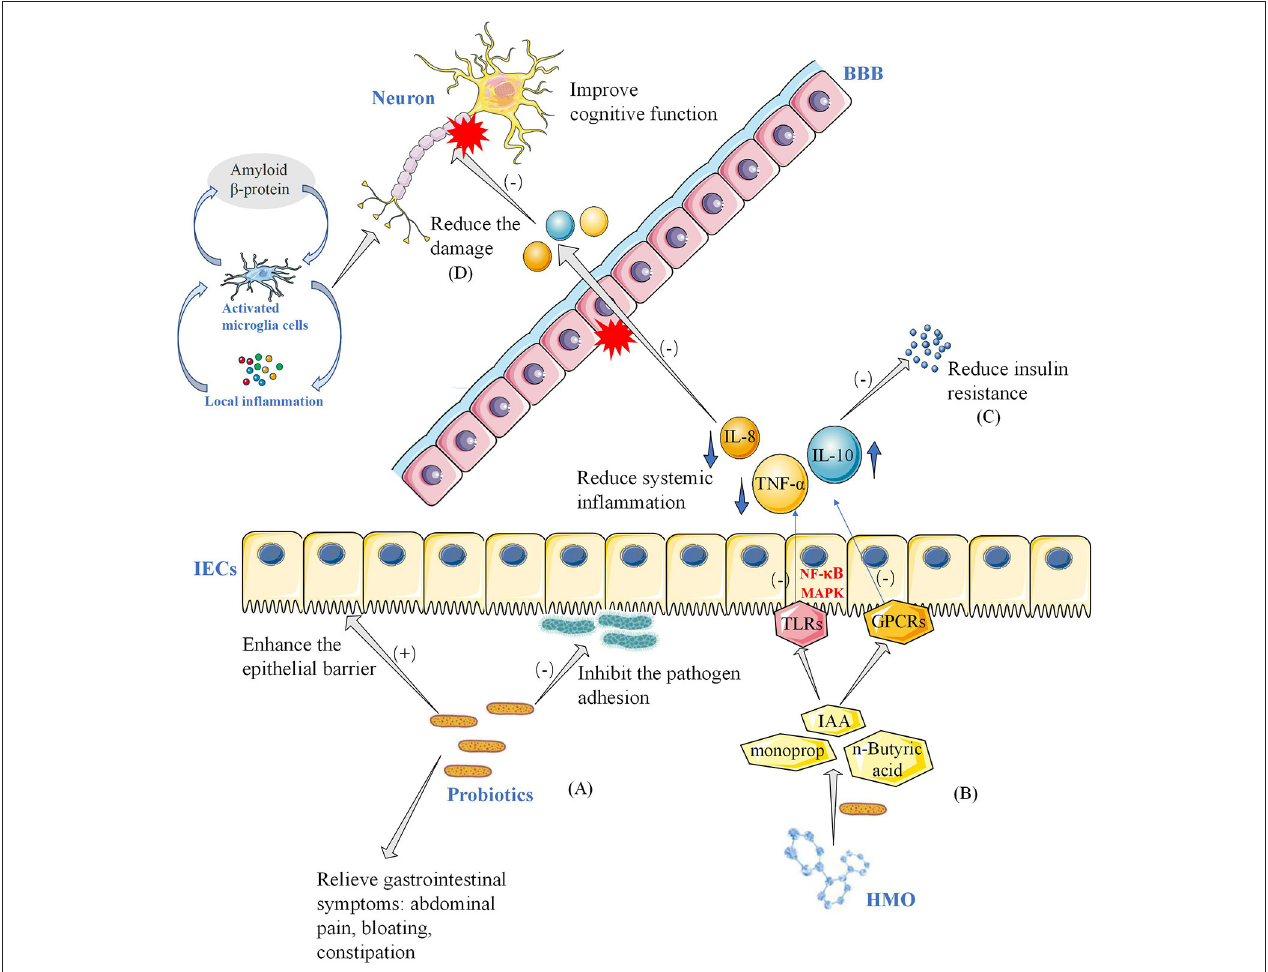
FIGURE 5 | Potential mechanisms of probiotics improving neurocognitive function and gastrointestinal symptoms. (A) In this model, probiotics in the intestinal tract strengthen the intestinal barrier and inhibit the attachment of pathogenic bacteria to the intestinal wall, thereby improving gastrointestinal symptoms such as abdominal pain, bloating, and constipation in patients with Parkinson’s disease. (B) Probiotics take HMO as substrate and decompose it into metabolites such as acetic acid. SCFA and other bacterial metabolites act on APC and IECs through toll-like receptors and GPCRs. Reduced systemic inflammation, including pro-inflammatory cytokines and anti-inflammatory cytokines, through NF- B and MAPK pathways. (C) Reduction of inflammation reduces insulin resistance on the one hand, and on the other hand (D) reduction of damage to the blood-brain barrier, reducing damage to neurons, and thus improving neurocognitive function. (E) HMO, human milk oligosaccharides; SCFA, short-chain fatty acids; GPCRs, G Protein-Coupled Receptors; APC, antigen-presenting cells; IECs, intestinal epithelial cells; NF- κ B, nuclear factor kappa-light-chain-enhancer of activated B cells; MAPK, Mitogen-activated protein kinase; IL-10, interleukin 10; IL-8, interleukin 8; TNF- α ,